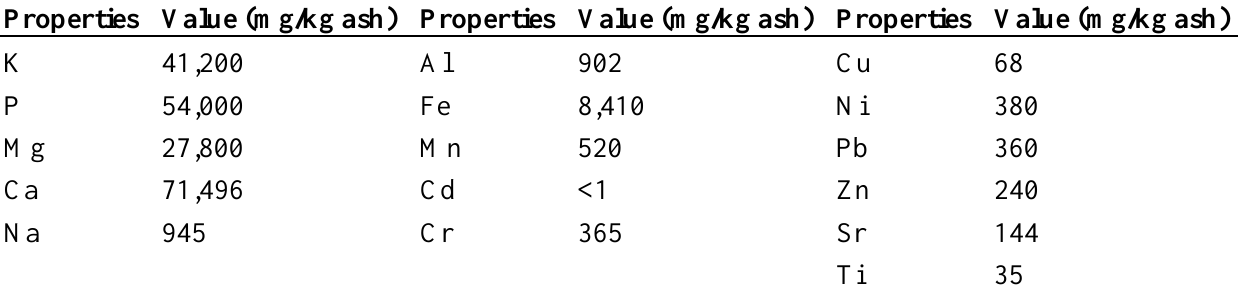
Table 5. Cyclone ash